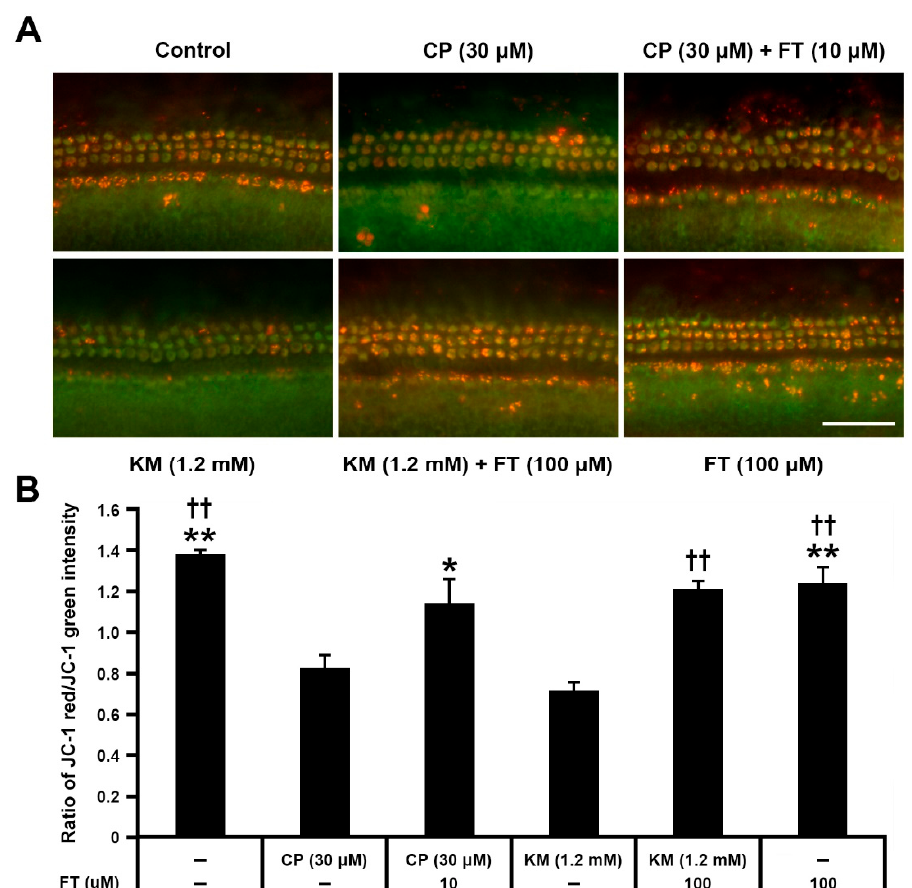
Figure 4. FT inhibits mitochondrial membrane potential disruption in mouse cochlear explants. JC-1 assay exhibiting membrane potential-dependent accumulation of JC-1 aggregates in mitochondria. ( A ) Fluorescence images from Control, CP, CP + FT, KM, KM + FT, and FT groups after 30 h of incubation ( n = 9, each). Images were acquired from the mid region of the organ of Corti. ( B ) Quantitative comparison of red-to-green fluorescence intensity ratios between each group. All groups contained 27 mice. Data are shown as mean ± SD. * p < 0.05 and **, †† p < 0.01 compared with the CP group. CP: cisplatin, KM: kanamycin, FT: fursultiamine. Scale bar, 50 µ m.